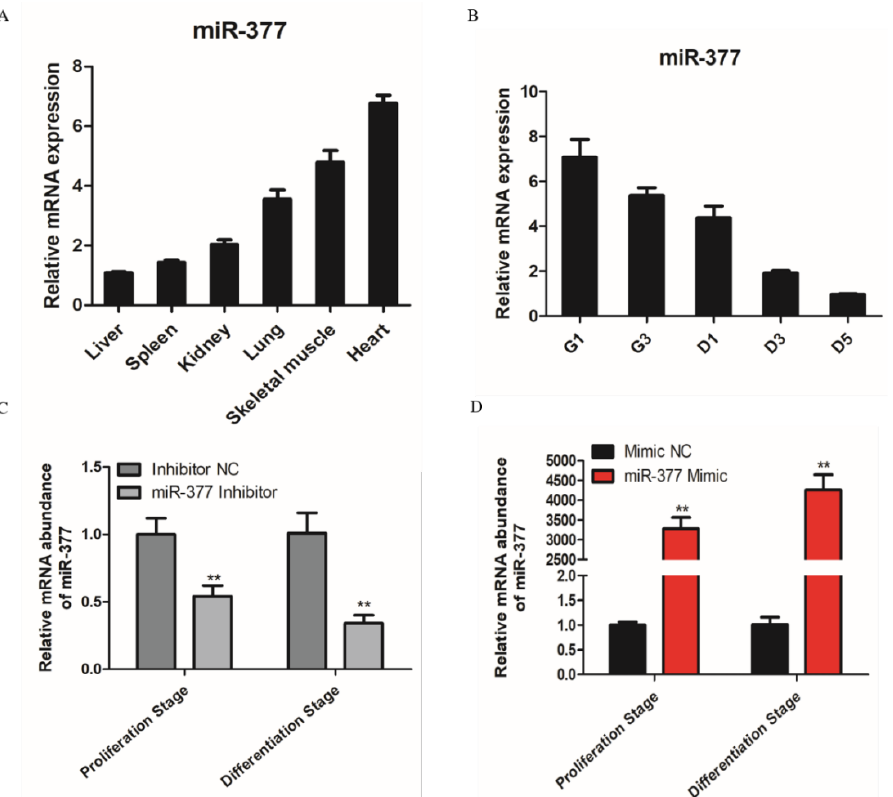
Figure 1. Expression pattern of miR-377 in bovine. ( A ) Expression levels of miR-377 in bovine heart, liver, spleen, lung, kidney and skeletal muscle. ( B ) Expression levels of miR-377 in SMSCs cultured in either GM for 1d and 3d (G1 and G3) or in DM for 1, 3 and 5d (D1, D3 and D5). ( C ) The expression levels of miR-377 in bovine SMSCs transfected with inhibitor NC and miR-377 inhibitor. ( D ) The expression levels of miR-377 in bovine SMSCs transfected with Mimic NC and miR-377 Mimic. Data are expressed as mean ± SEM ( n = 3). ** p < 0.01.